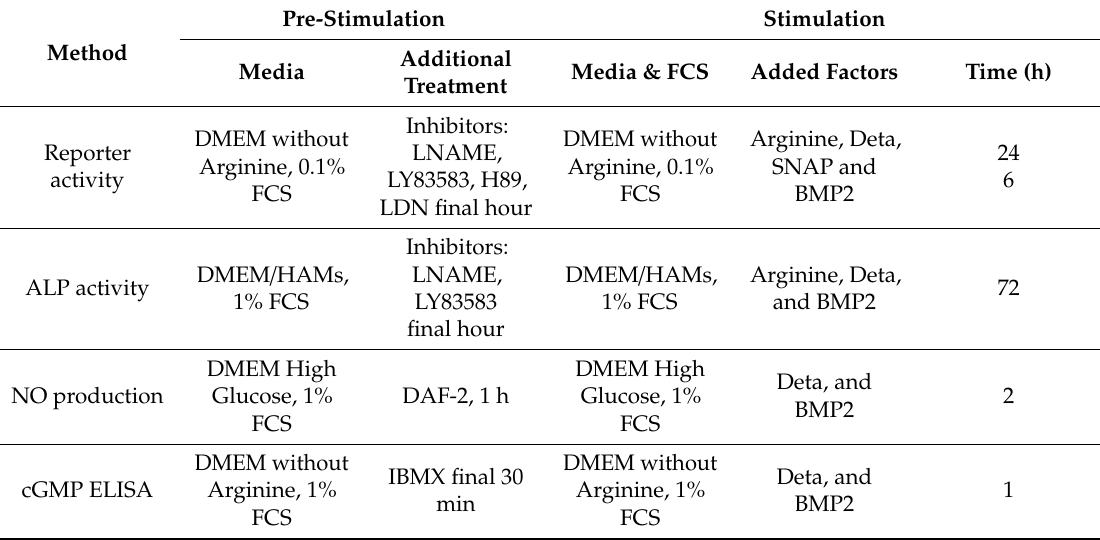
Table 1. Experimental setups for this